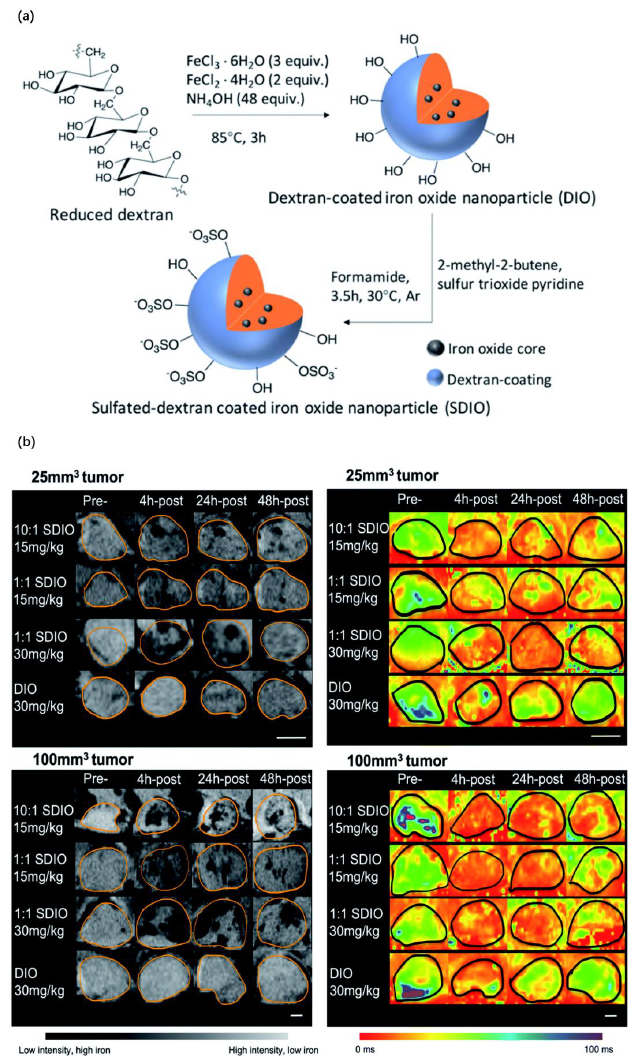
Figure 3. ( a ) Synthetic route of SDIO/DIO. ( b ) Representative zoomed in MR images and parametric T2* maps for 25 mm 3 tumor and 100 mm 3 tumor models injected with either 15 mg Fe kg −1 10:1